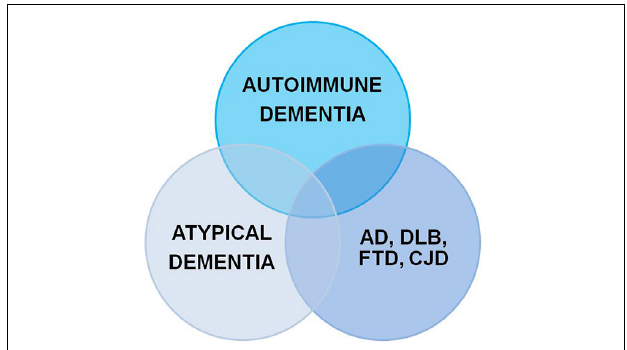
FIGURE 1 | Neural autoantibodies shared by different dementia subtypes. AD, Alzheimer’s disease; DLB, dementia with Lewy bodies; CJD, Creutzfeldt-Jakob disease; FTD, frontotemporal dementia.